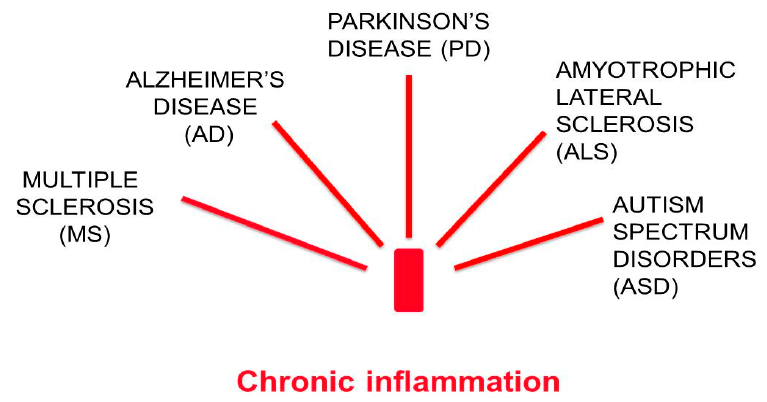
Figure 1. Chronic neurodegenerative diseases have a chronic inflammatory basis in common.